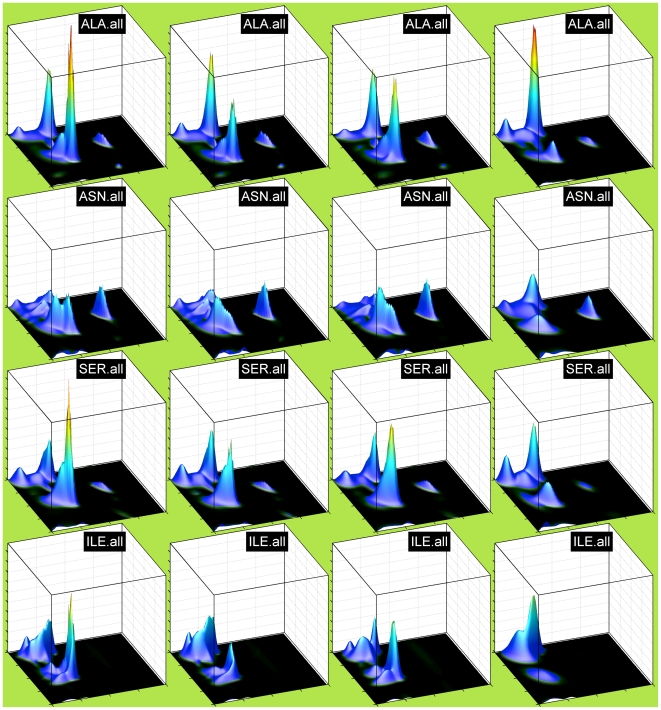
Comparison of different data sets for neighbor-independent Ramachandran distributions for 4 amino acid types.Rows (from top to bottom): Lys, Met, Leu, Glu. Columns (from left to right): TCBIG, TCB, Tonly, Conly. All plots are scaled to a common maximum probability height.